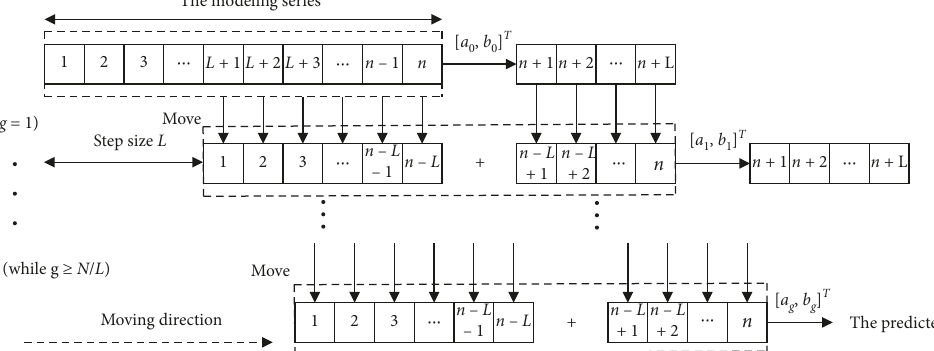
Figure 1: Grey modeling mechanism based on moving window algorithm.